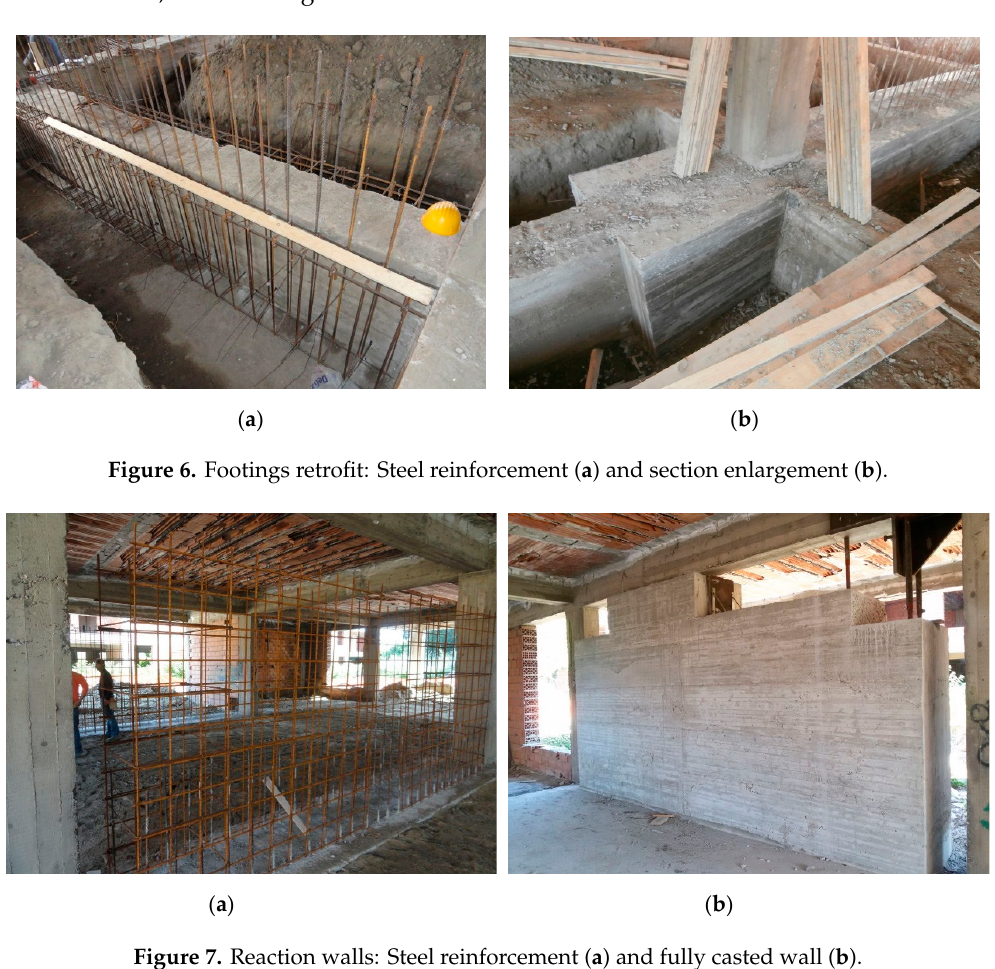
Figure 7. Reaction walls: Steel reinforcement ( a ) and fully casted wall ( b